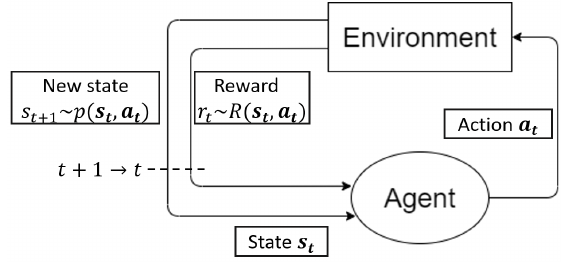
Figure 1. Markov decision